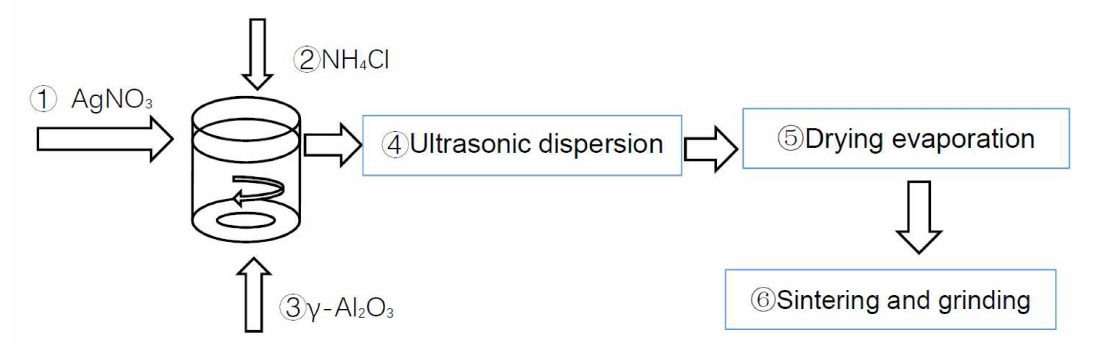
Figure 1. Material preparation